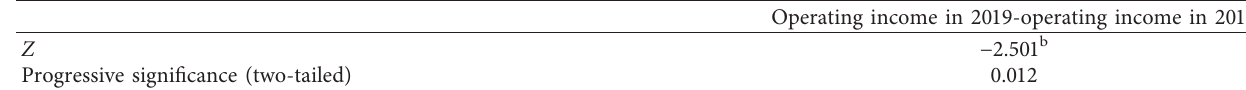
Table 4: Test statistics a